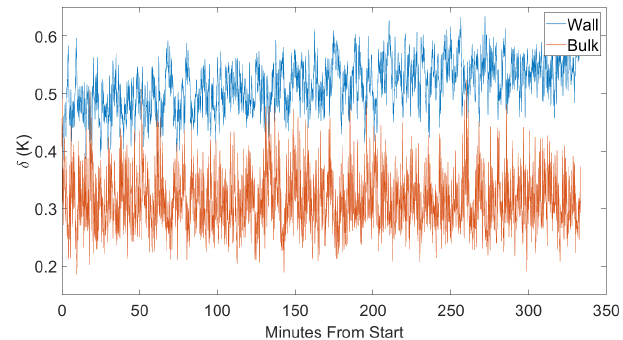
Figure 8. The amplitude ( δ ) of the large-scale circulation for a (cid:49)T = 12K along the wall (red) and 30cm towards the center (blue). The amplitude near the wall is consistently higher than in the bulk.